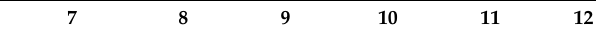
Table 4. Means, Reliabilities, and Correlations Among the Four Teaching Styles and Eight Identified Subareas in